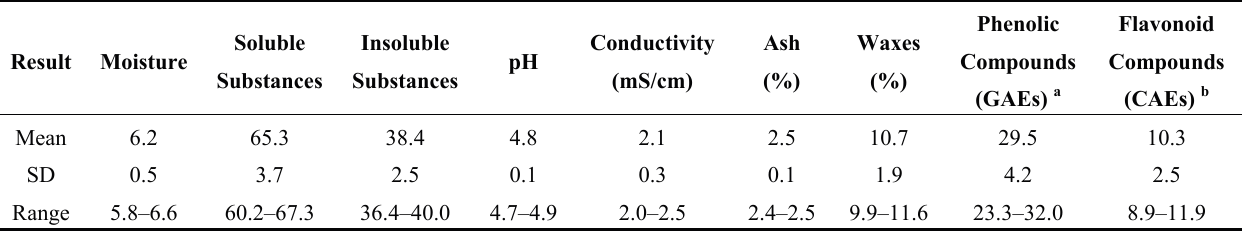
Table 2. Physicochemical characteristics of the propolis samples.